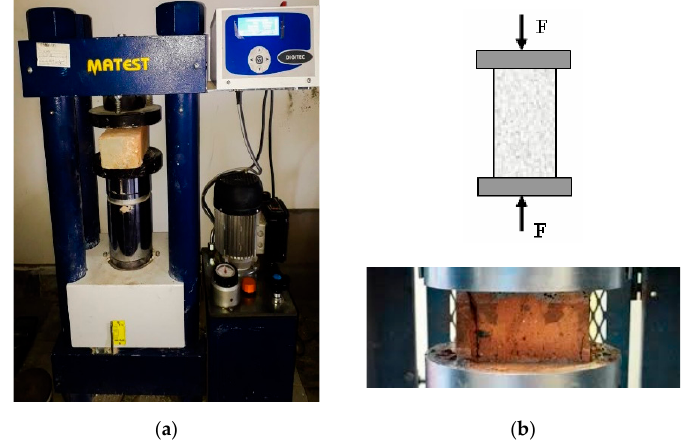
Figure 5. ( a ) Compression machine with brick. ( b ) Compressive strength concept.